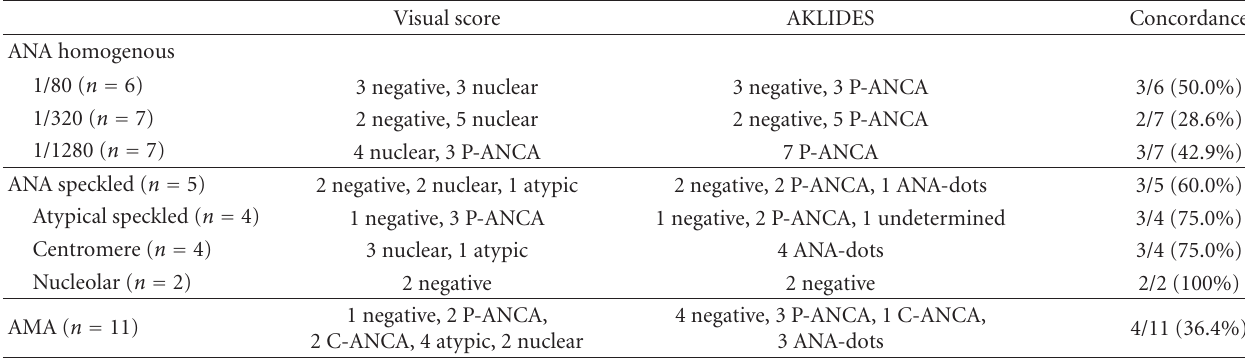
Figure 1: Pattern recognition by AKLIDES in sera of ANCA-associated vasculitis patients with C-ANCA/PR3-ANCA ( n = 39; (a) and (c)) and P-ANCA/MPO-ANCA ( n = 40; (b) and (d)) on ethanol-fixed neutrophils ((a) and (b)) and formalin-fixed neutrophils ((c) and (d)). Notably, P-ANCA samples are expected to reveal a C-ANCA pattern on formalin-fixed neutrophils (d). ANCA patterns were scored by routine fluorescence microscopy (black bars represent unequivocal, correct pattern recognition; intermediate grey bars on top of the black bars represent weak, but correct pattern recognition) and by AKLIDES (dark grey bars represent unequivocal, correct pattern recognition; light grey bars on top of the dark grey bars represent weak, but correct pattern recognition). Red and pink bars represent erroneous pattern recognition by routine fluorescence microscopy and AKLIDES, respectively, dotted bars indicate that the pattern was undetermined by AKLIDES. Data are expressed as percentage for each titre category; titres were historically measured during routine diagnostics. Table 1: Interference of ANCA pattern recognition in sera containing ANA or AMA. Visual score AKLIDES